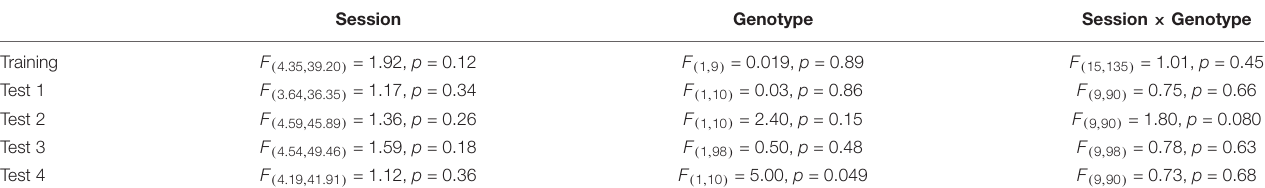
TABLE 2 | Error perseveration.